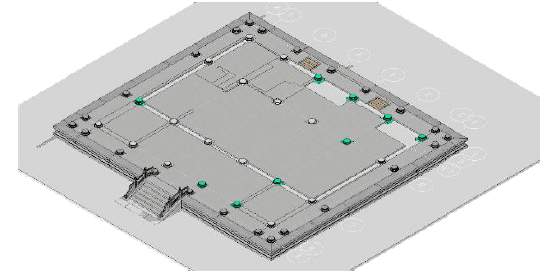
Figure 3. the base of Jingfu